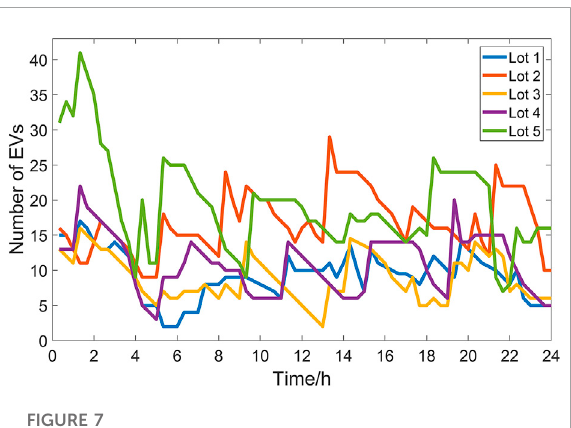
FIGURE 7 Distribution of the number of electric vehicles in coordinated charging and discharging stacks within 24 h.